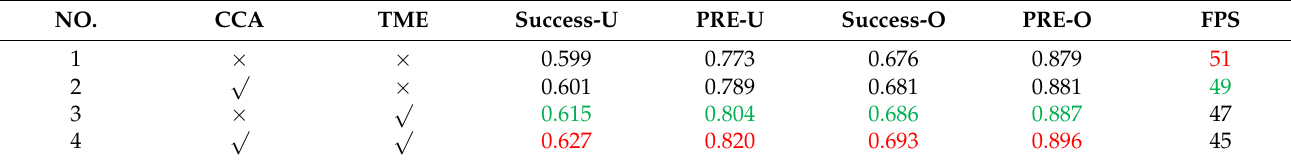
Table 3. Comprehensive evaluation results with or without the proposed blocks on multiple datasets. Success-U and PRE-U represent the success rate and precision on the UAV123 benchmark; Success-O and PRE-O represent the success rate and precision on the OTB100 benchmark. FPS represents the selected results on the GOT-10K benchmark. The best method is shown in red, and the second is shown in